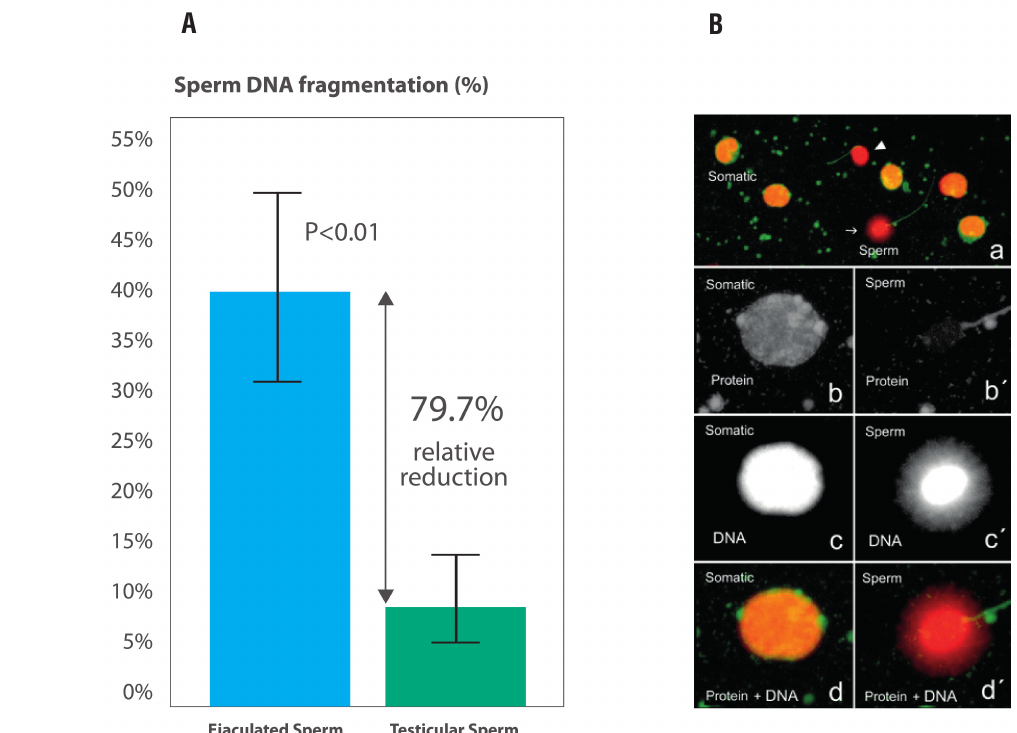
figure 1 - comparison of sperm DNA fragmentation rates in ejaculated and testicular sperm of 81 infertile men undergoing IcSI: (A) Use of testicular sperm for IcSI resulted in an absolute reduction of 32.6% (relative reduction of 79.7%) in SDf; (B) Sperm chromatin dispersion (ScD) test for assessing SDf in testicular sperm. A variant of the Halosperm test (Halotech DNA, Spain) that combines a dual fluorescent cocktail probe to discriminate somatic cells from spermatozoa was used. Spermatozoa and somatic cells exhibit differences in the wavelength emission associated with each fluorochrome (green for proteins and red for DNA). Spermatozoa exhibit only red fluorescence on the sperm head owing to protamine removal, while non-sperm cells fluoresce yellow as a result of the combined emission of both fluorochromes (A). Spermatozoa exhibiting red fluorescence with a green flagellum and no halo of chromatin dispersion represented those with fragmented DNA (arrow cap). In contrast, spermatozoa exhibiting red fluorescence with a green flagellum and haloes of chromatin dispersion represented those with non-fragmented DNA (arrow). A somatic cell with its typical high protein and DNA contents and a spermatozoon with its characteristic low protein remnant and high DNA content are seen in B and c, respectively, using a single channel fluorescence emission. After merging the information provided by protein and DNA selective staining, somatic cells and spermatozoa can be easily distinguished (d and d’). In addition, the sperm tail fluoresces in green, and this feature also helps to distinguish spermatozoa from other cell elements (a and d’). Adapted with permission from Esteves et al.